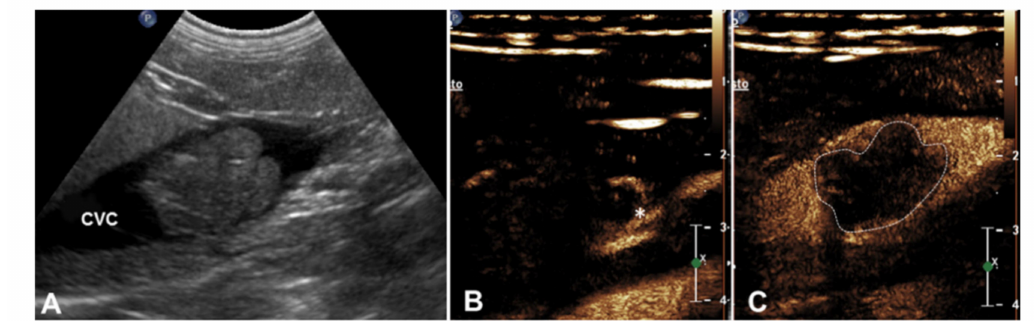
Figure 1. ( A ) Two-dimensional and ( B , C ) contrast-enhanced images of malignant thrombosis involving the caudal vena cava in a dog with right adrenal carcinoma (case 4). ( A ) Hyperechoic, solid thrombus is seen in the caudal vena cava (CVC), with a focal dilation of the vessel; ( B ) evidence of the enhancement of a tortuous newly formed vessel inside the thrombus (*), while caudal vena cava is still anechoic (Anticipated wash-in); ( C ) inhomogeneous wash out of the thrombus (dotted) while the contrast medium is still present on the lumen of the caudal vena cava